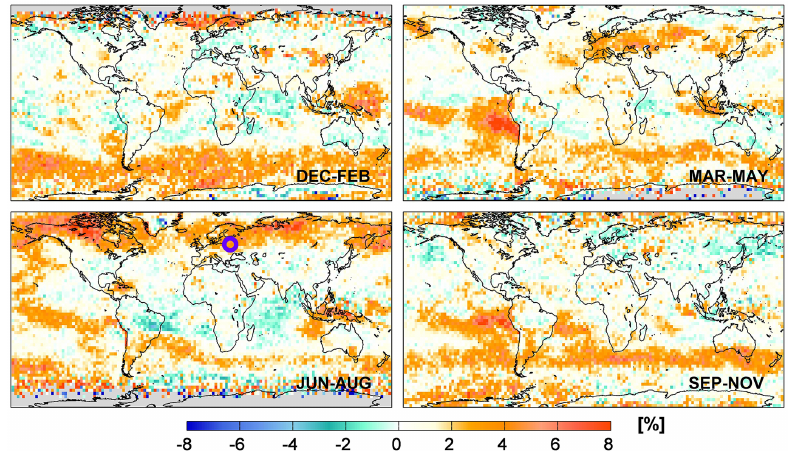
Figure 4. Seasonal distribution of the differences between the RMSE of the regression fits with and without the linear trend term [(RMSE _w/o_LT − RMSE _with_LT ) / RMSE _with_LT × 100] (in percent). The blue circle in the JJA panel refers to the case presented in Fig. 3.